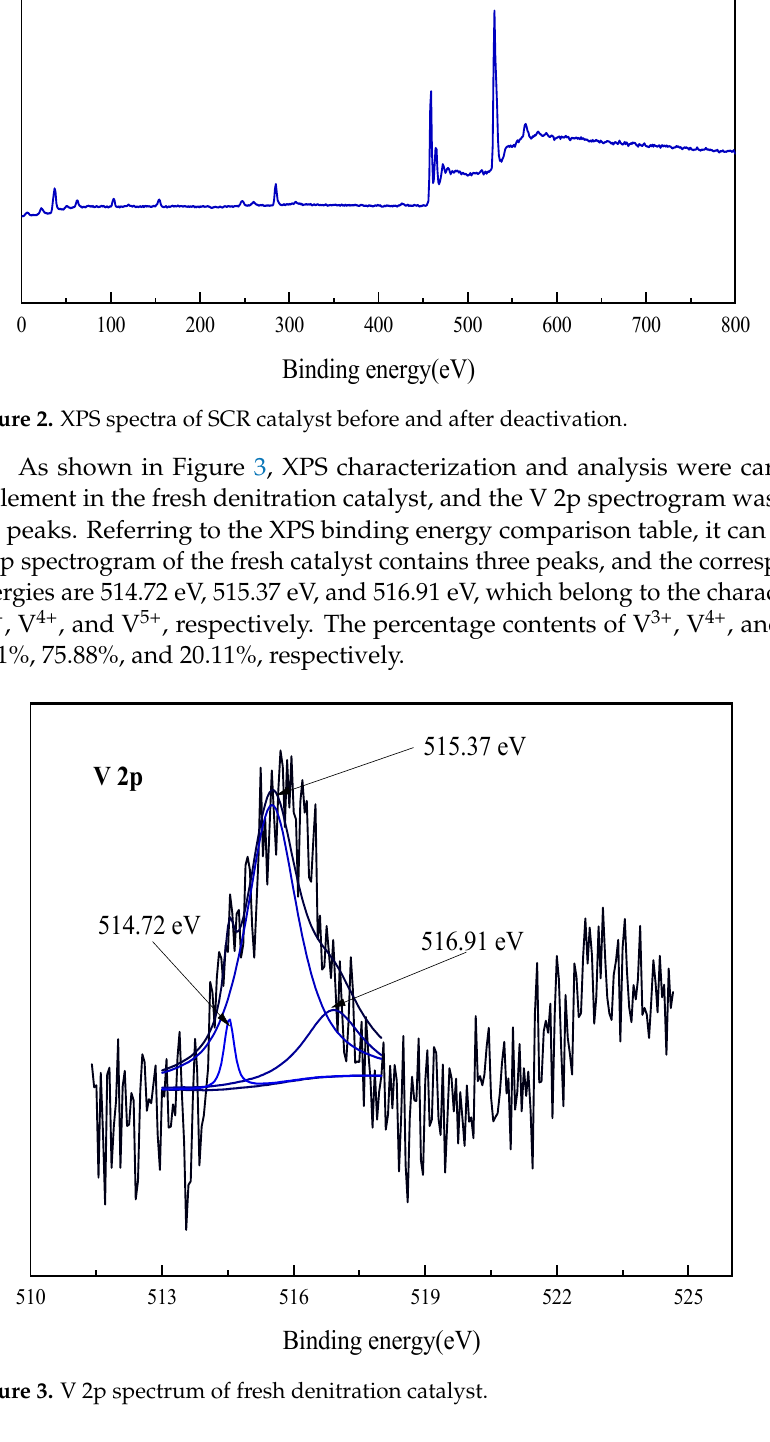
Figure 3. V 2p spectrum of fresh denitration catalyst.